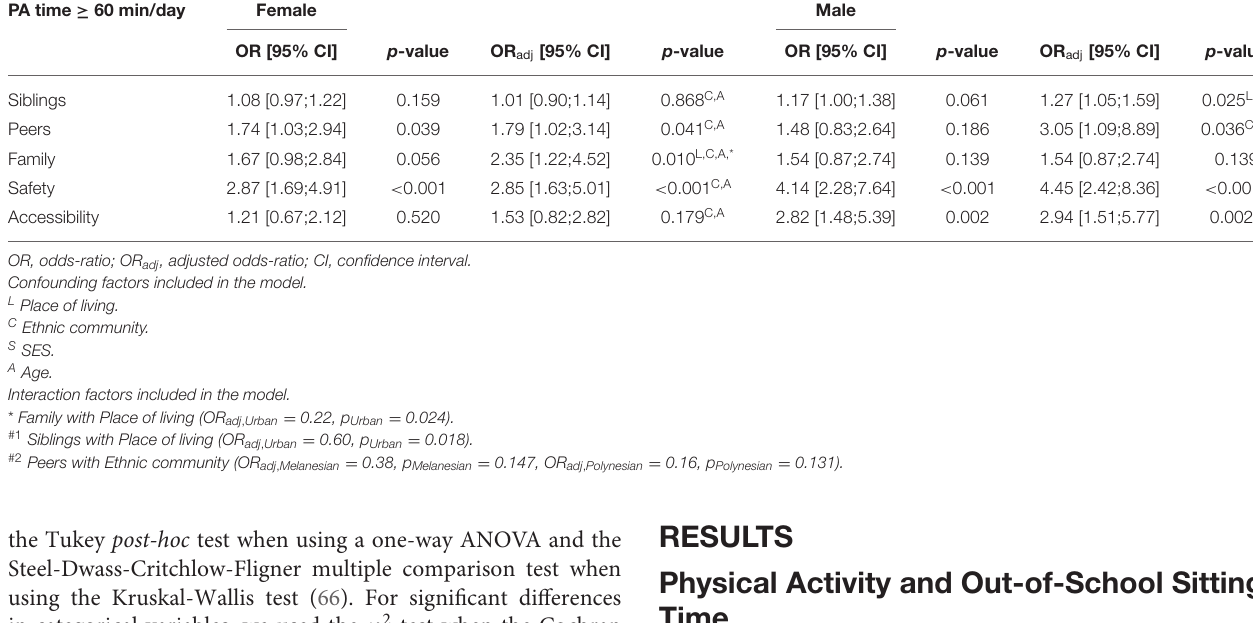
TABLE 1 | Associations between PA time and socioenvironmental factors one by one adjusted with the confounding factors (place of living, ethnic community, age) and interactions. PA time ≥ 60